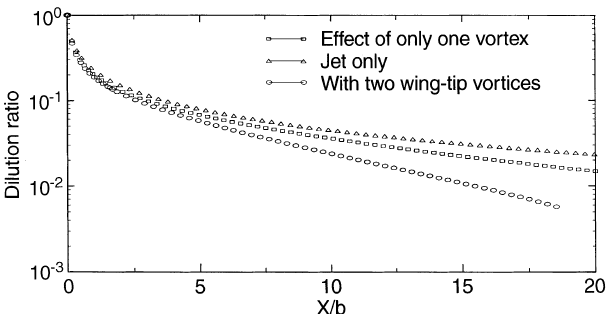
Fig. 6. E(cid:128)ect of the wing-tip vortices on the dilution ratio of a twin- engine A-330, obtained using integral